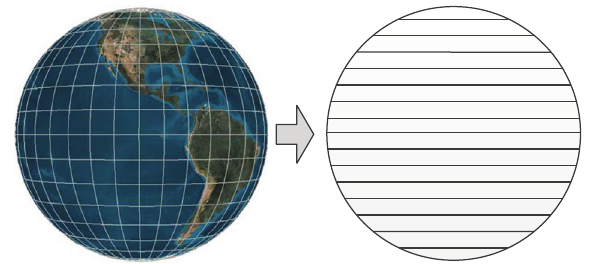
Figure 1: Global division by latitude stripe